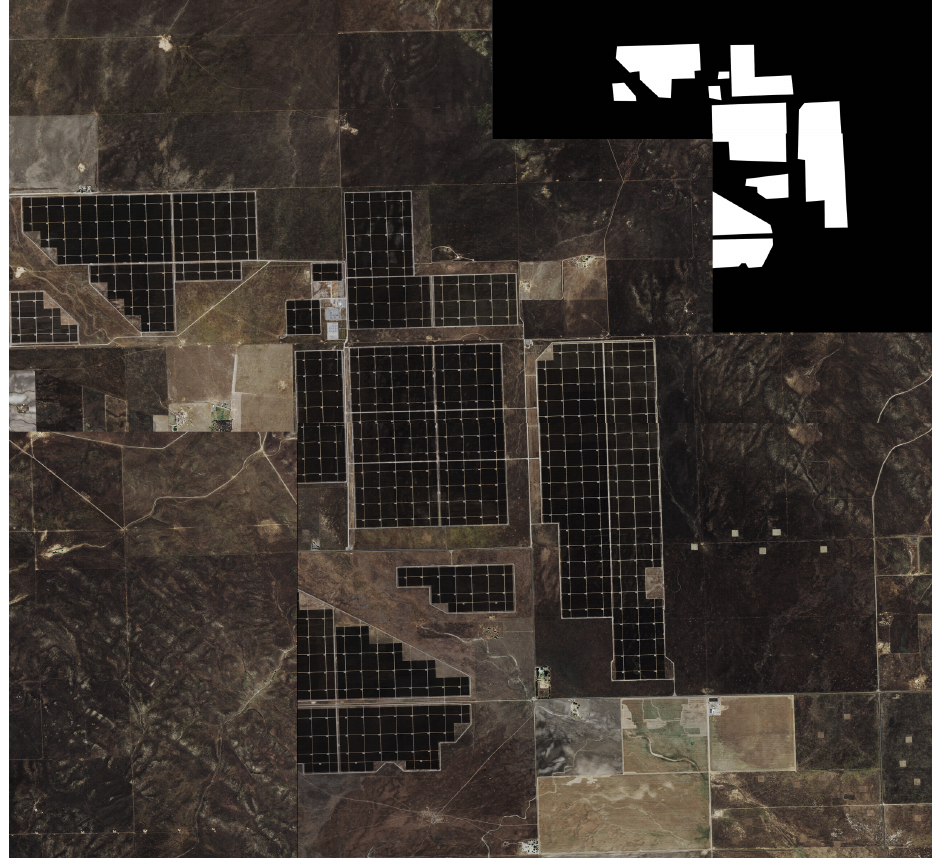
Figure A4. Topaz Solar (35 ◦ 23 (cid:48) N, 120 ◦ 4 (cid:48) W) , along with its corresponding